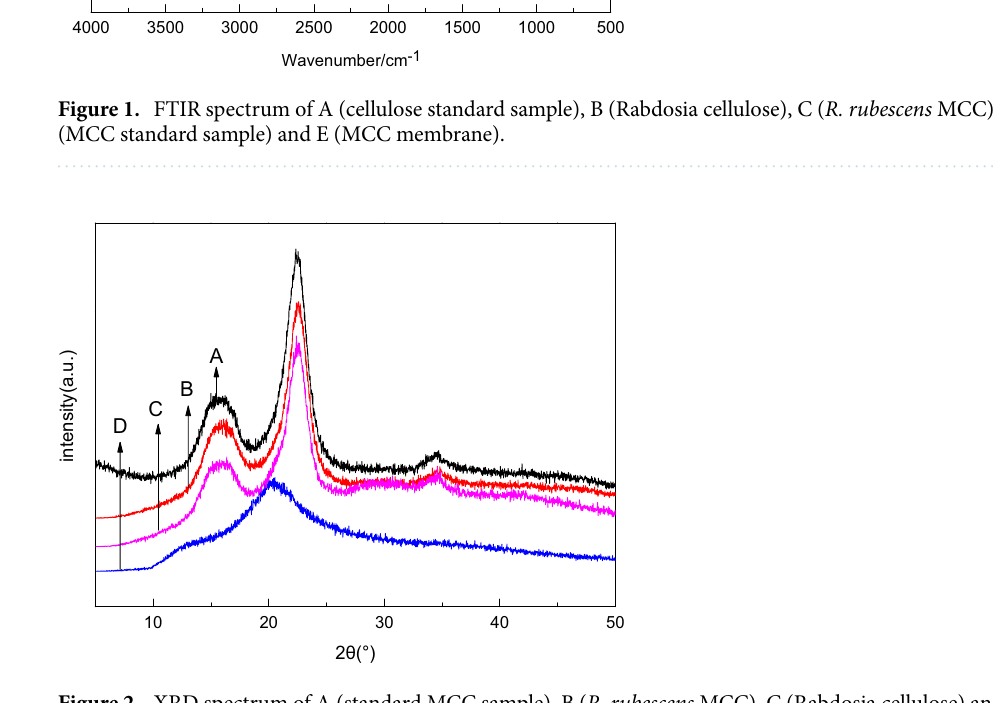
Figure 2. XRD spectrum of A (standard MCC sample), B ( R. rubescens MCC), C (Rabdosia cellulose) and D (MCC